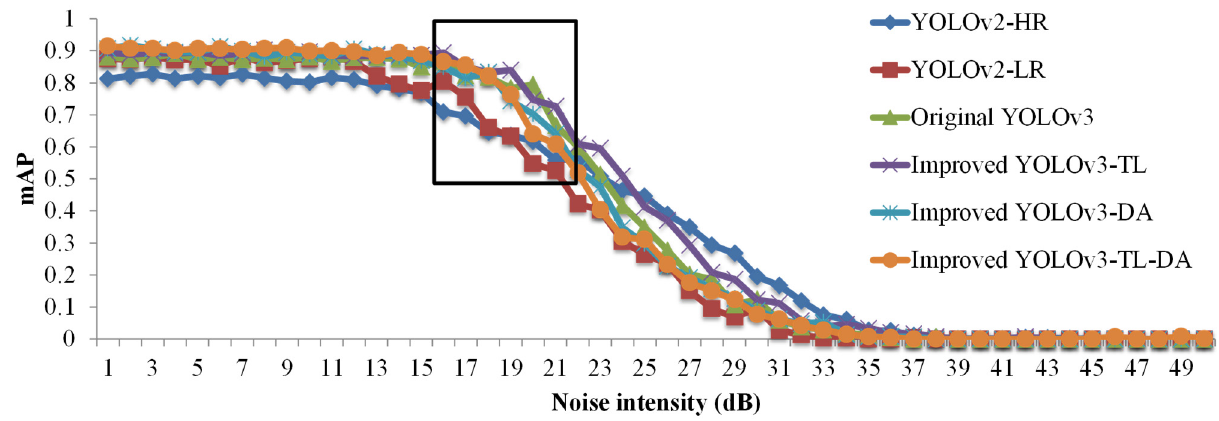
Figure 15. Comparisons of the YOLOv2 and YOLOv3 with influence of WGN.